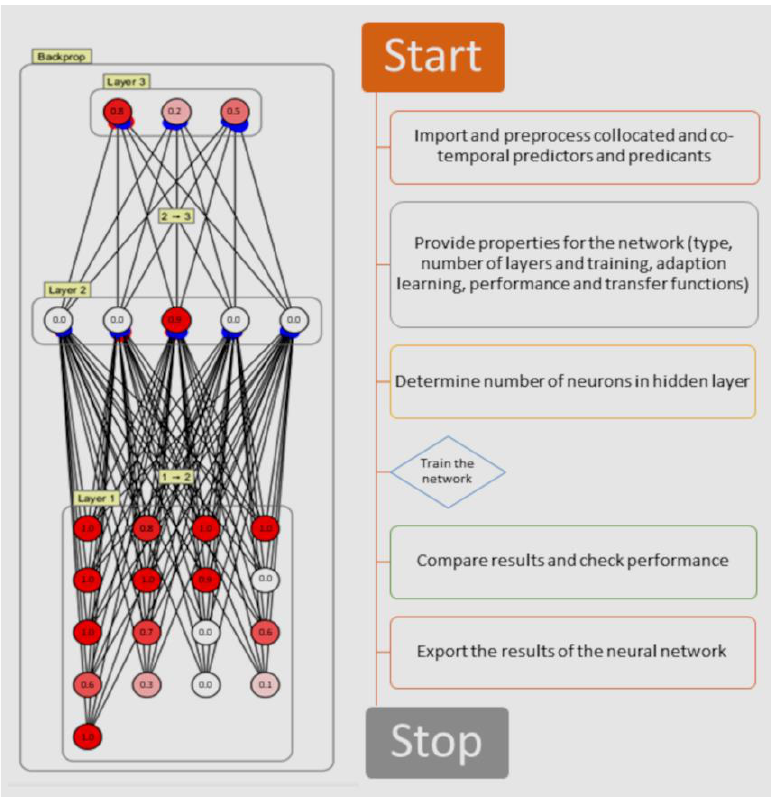
Figure 4. The network architecture of the BPN model (left) showing 5 neurons in the hidden layer and the respective weights (in red and blue) of each connection. The values in each of the neurons is a scaled down value (1 decimal place) of the input, hidden, and output neurons, corresponding to one possible solution between the proxy environmental drivers (predictors) and the values for DIC, TA, and pH (predictands). Layer 1 (input): 17 neurons (see Table 1 for a list of input neurons). Layer 2 (hidden): 5 neurons. Layer 3 (output): 3 neurons: DIC, TA, and pH. Steps involved in the development of the BPN model (right).